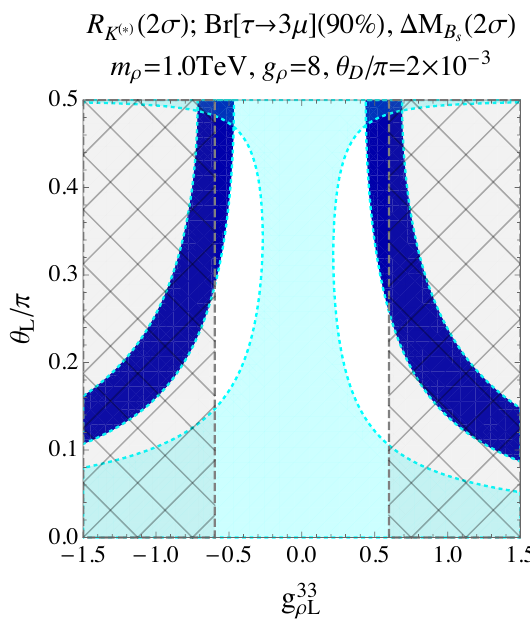
Figure 3 . The region plot in the plane ( g 33 ; (cid:18) L ) with (cid:18) D =(cid:25) = 2 (cid:2) 10 (cid:0) 3 fixed for m (cid:26) = 1 TeV and (cid:26)L g (cid:26) = 8 . The current R anomaly can be explained in the thick-blue region at the 2 (cid:27) level, while K ( (cid:3) ) the cyan-shaded area represents the consistent region with the current 90% C.L. upper limit of Br [ (cid:28) (cid:0) ! (cid:22) (cid:0) (cid:22) + (cid:22) (cid:0) ] (see figure 1). The gray-hatched region is out of the 2 (cid:27) -favored area for (cid:1) M B (see figure 2).